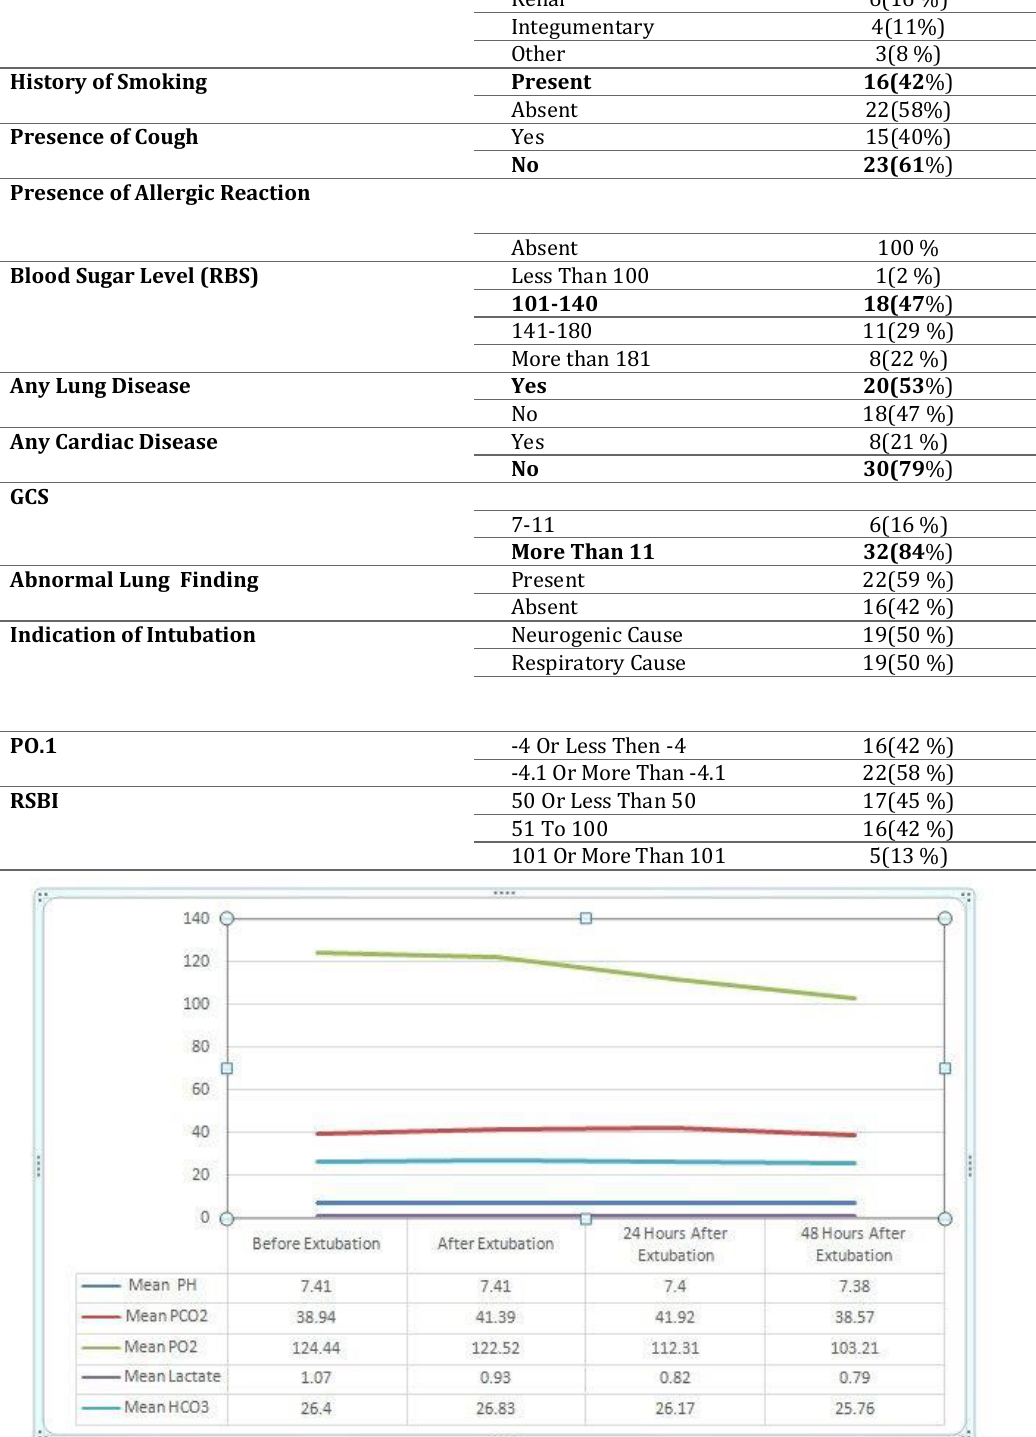
Table 2. Clinical Variable of study participants